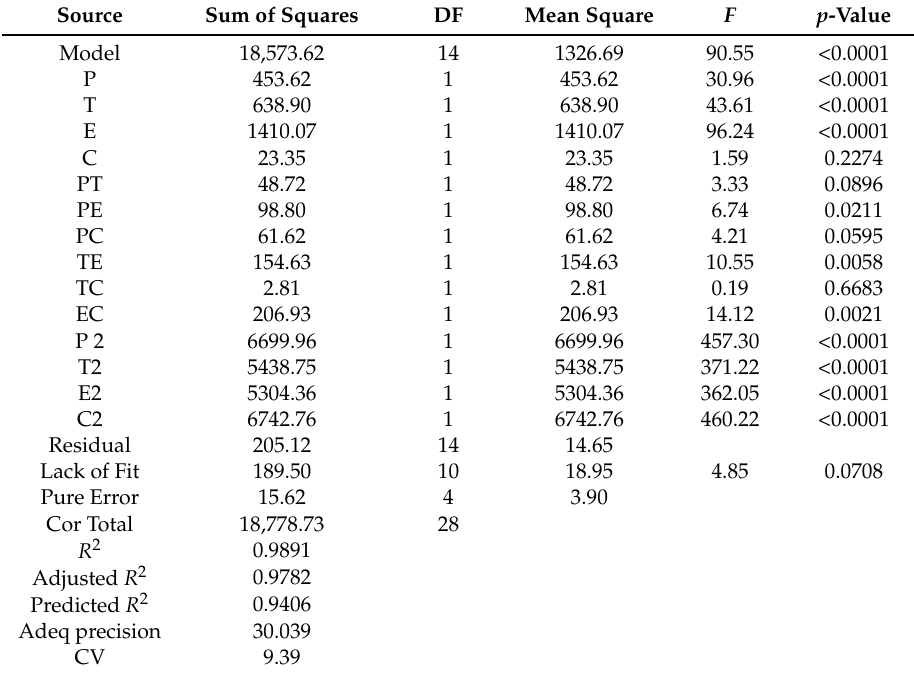
Table 3. ANOVA analysis for the response surface quadratic model ( α =